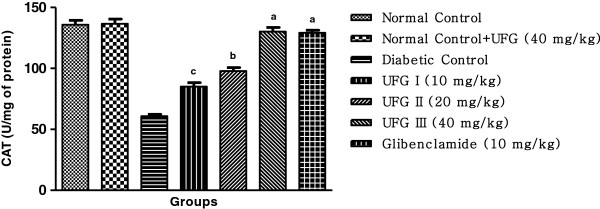
Effect of umbelliferone β-D-galactopyranoside on level of CAT (Catalase) cholesterol at different concentrations on STZ induced diabetic rats, compared to diabetic control group rats; values are mean ± SEM; n = 6;
c
P < 0.05;
b
P < 0.01;
a
P < 0.001; P > 0.05 is considered as non-significant (ns).